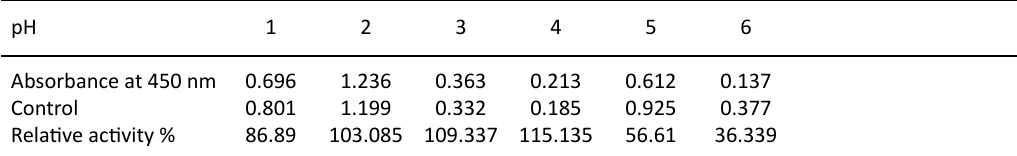
Table 7. Absorbance of the enzyme at different temperature Celsius 10˚ Absorbance at 450 nm Control